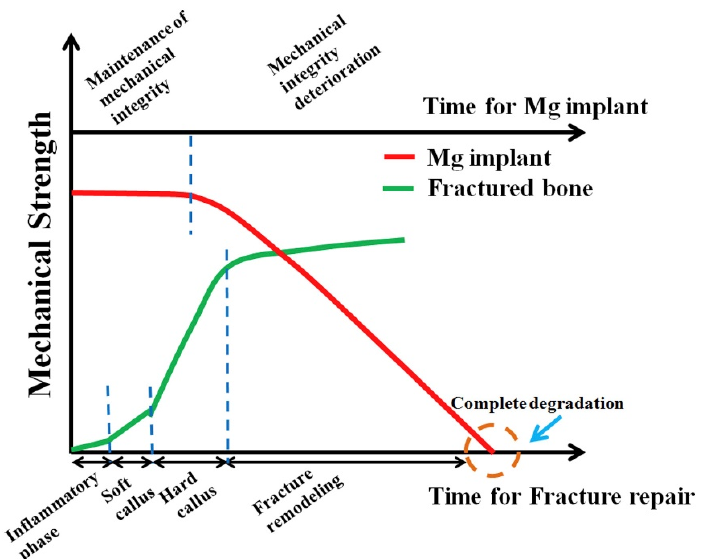
Figure 11. A schematic diagram illustrating the relationship between degradation behavior and mechanical integrity change of Mg-based implants during the bone healing process. Reproduced with permission from [140]. Copyright 2016, Elsevier.